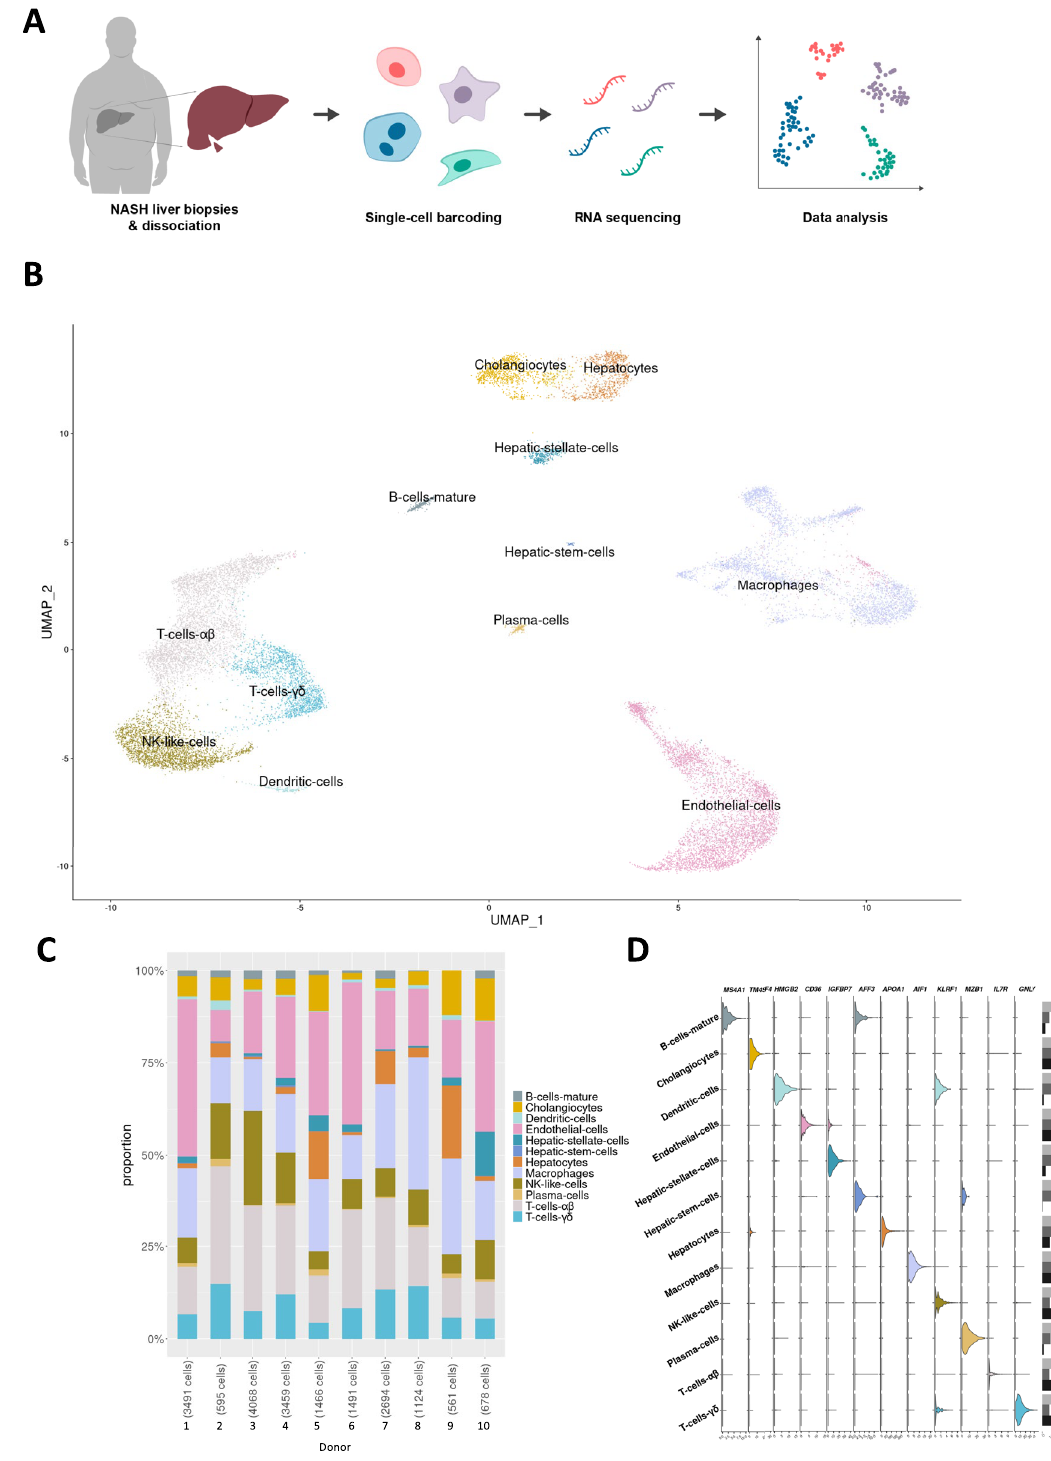
Figure 1. Single-cell analysis of human liver from obese patients with NASH. ( A ) Schematic diagram of the single-cell analysis workflow and analyses. Wedge biopsies from obese patients with NASH were dissociated enzymatically followed by single-cell barcoding, sequencing and data analysis. ( B ) UMAP projection of 19,627 cells showing the assigned identity for the main cell types in the liver, annotated by transfer of labels from previously published data sets. ( C ) Bar graph showing the proportion of cell types in each donor sample. ( D ) Left: Violin plots showing expression of selected marker genes for 12 distinct coarsely clustering cell types. The expression values are normalised, corrected for sequencing confounders and batch corrected for differences in average and variance between donor samples. Right; median number of RNA molecules, median number of genes and total number of cells in each